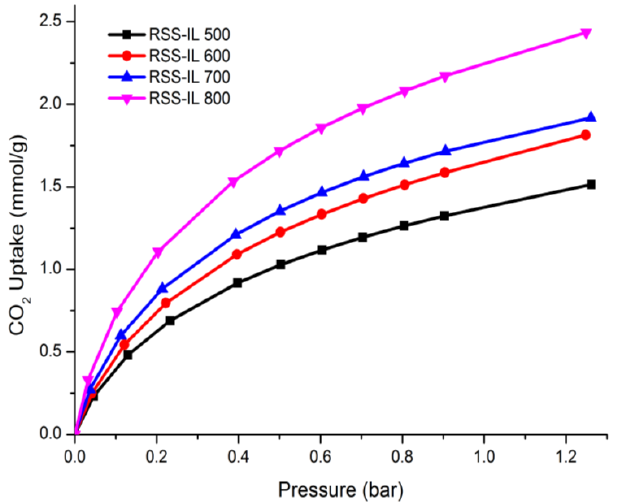
Figure 8. CO 2 adsorption isotherm of the prepared AC at different carbonization